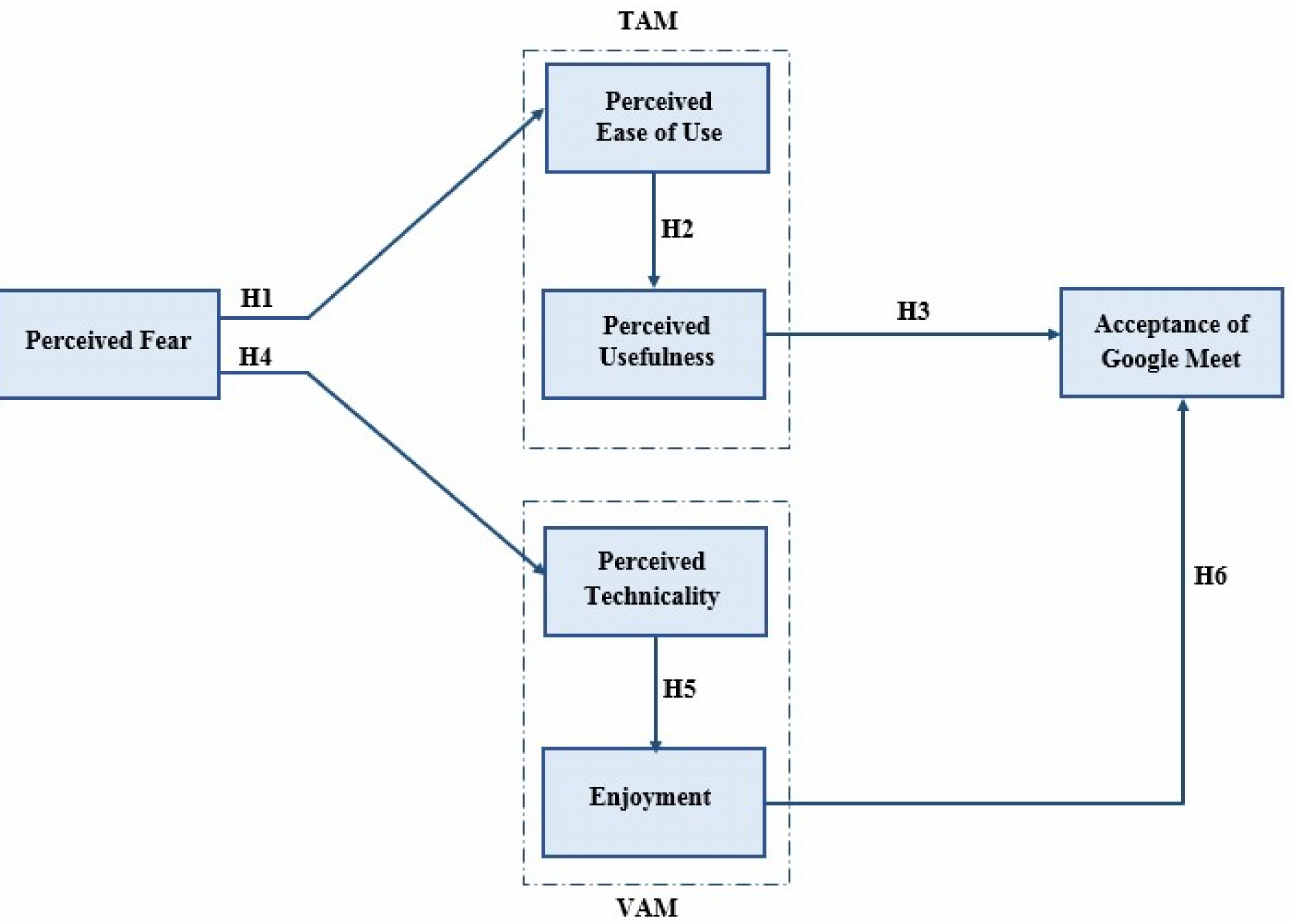
Figure 1. Research